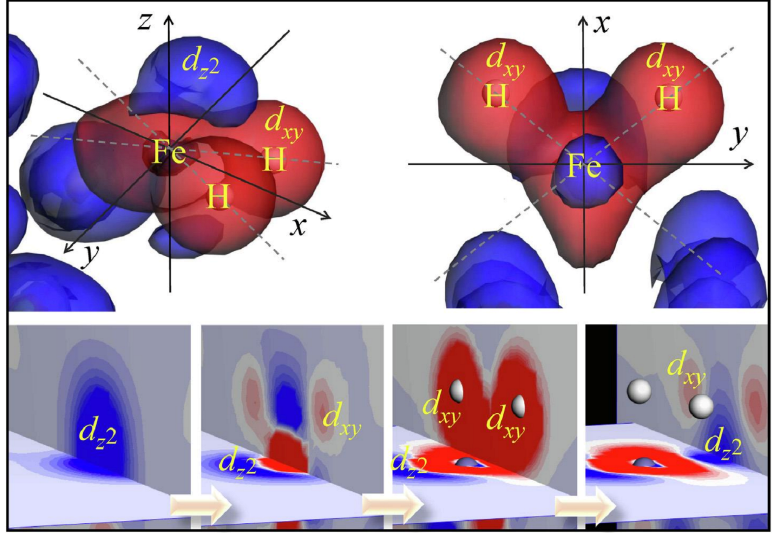
Figure 22. Deformation charge density distributions for the TS of H 2 dissociation on atomic-Fe- adsorbed Mg(0001). The red and blue indicate electron enrichment and depletion regions, respectively. Here, d z2 is the filled d orbital, which contributes the electrons during dissociation; d xy is the unfilled d orbital, which accepts the electrons during dissociation. Reproduced with permission [187]. Copyright 2019,